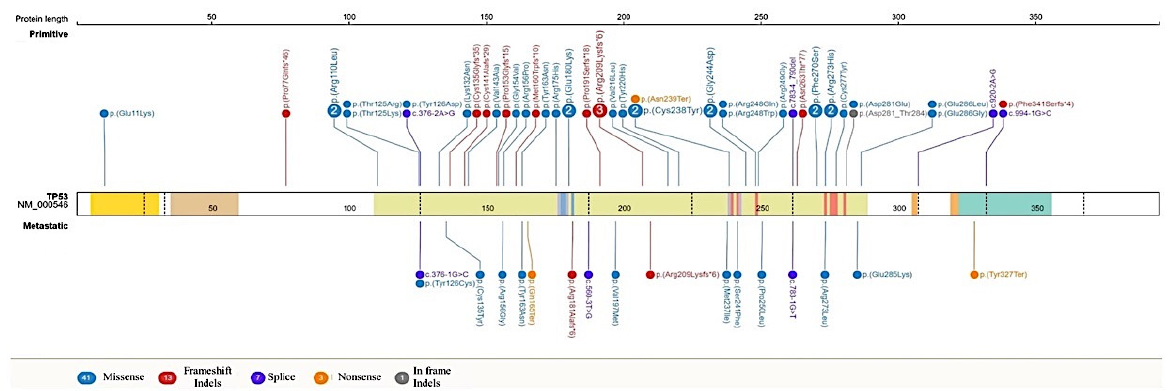
Figure 3. Distribution of TP53 variants in the context of a protein structure. The figure shows the linear maps of TP53 and the location of the genetic